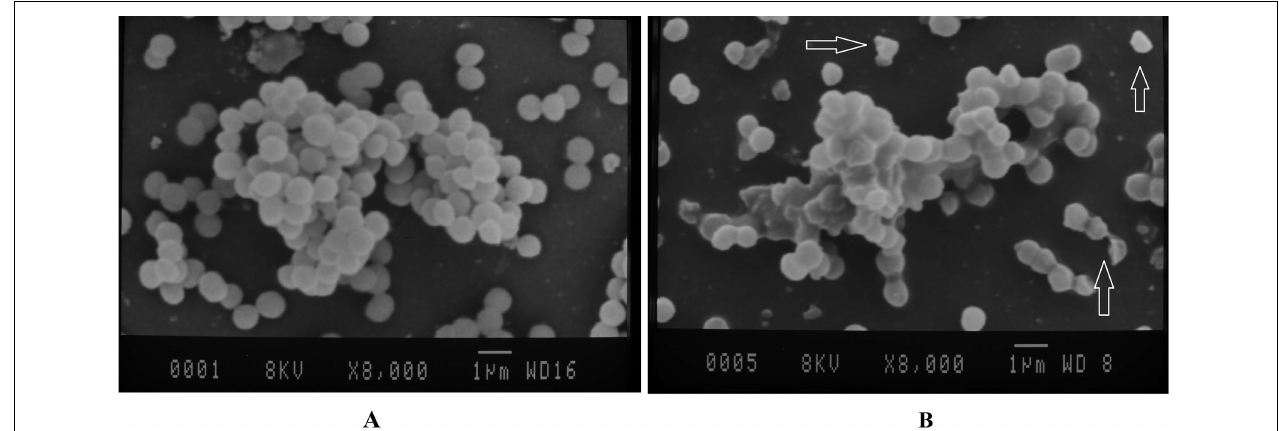
FIGURE 2 | SEM images of S. aureus on the coverslips. (A) Negative control (untreated bacteria). (B) Treated with the 1/2 MIC concentration of the CcEO (magnification: × 8,000). MIC, minimum inhibitory concentration.